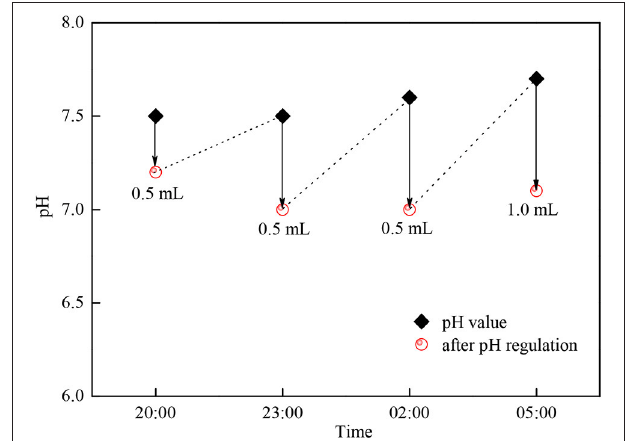
FIGURE 7 | The growth characteristic of Chlorella zofingiensis during the night time.